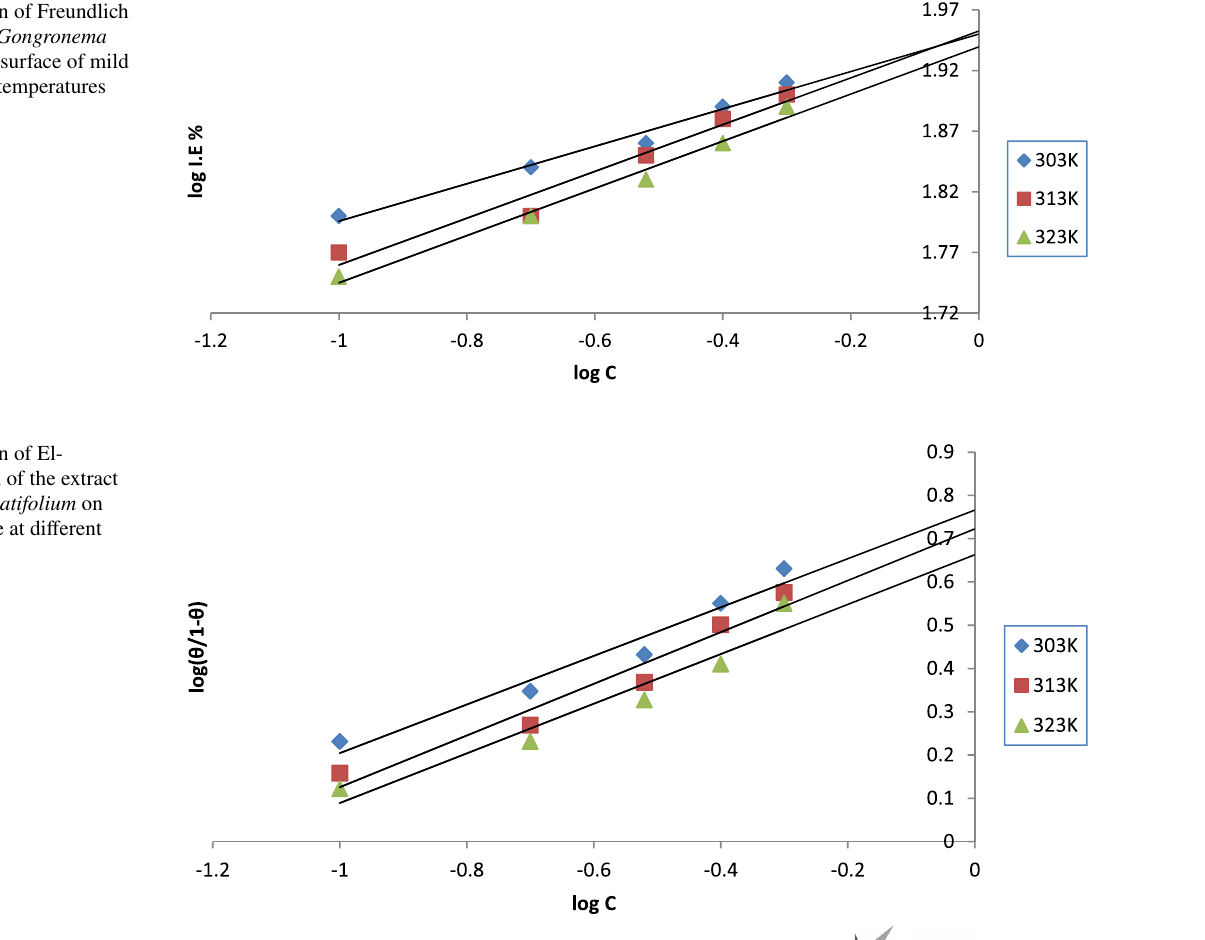
Fig. 5 Adsorption of El- Awardy isotherm of the extract of Gongronema latifolium on mild steel surface at different